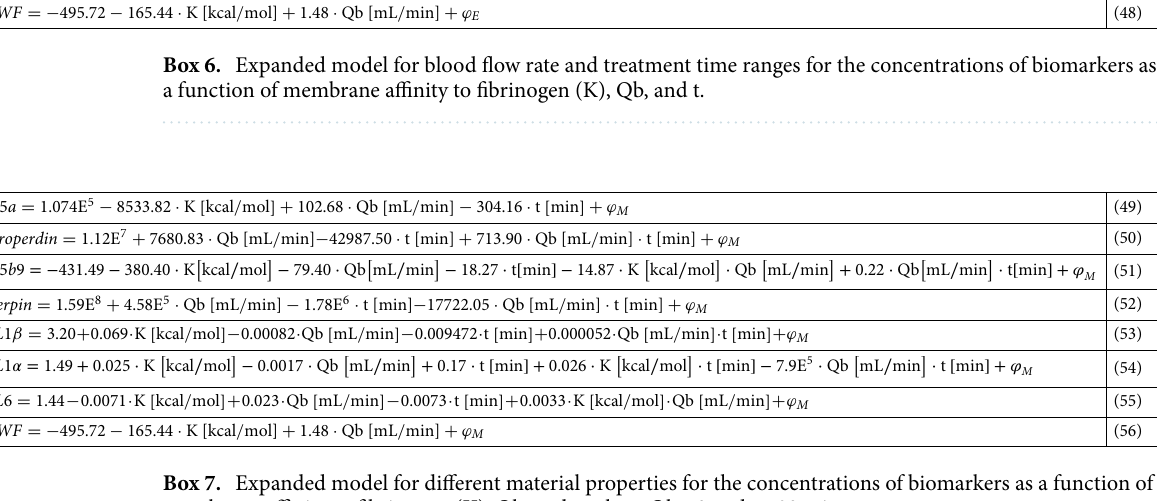
Box 7. Expanded model for different material properties for the concentrations of biomarkers as a function of membrane affinity to fibrinogen (K), Qb, and t, where Qb = 0 and t = 30